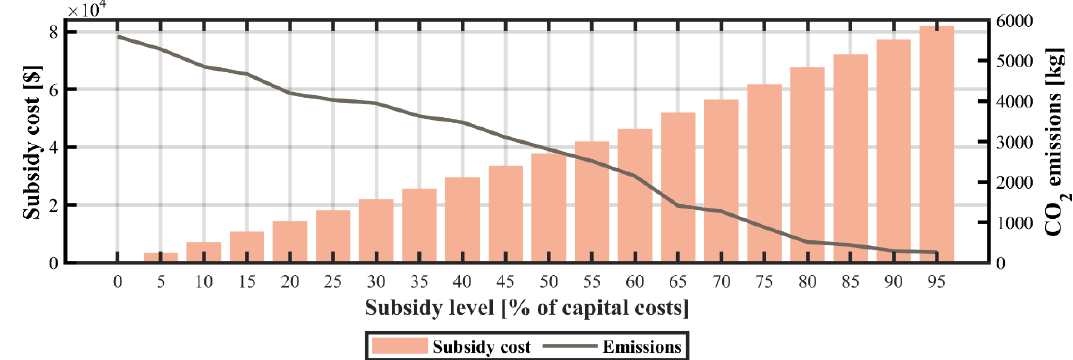
Figure 7. Simulation results of capital subsidies across all DG technologies. Impact on subsidy costs and CO 2 emission levels.